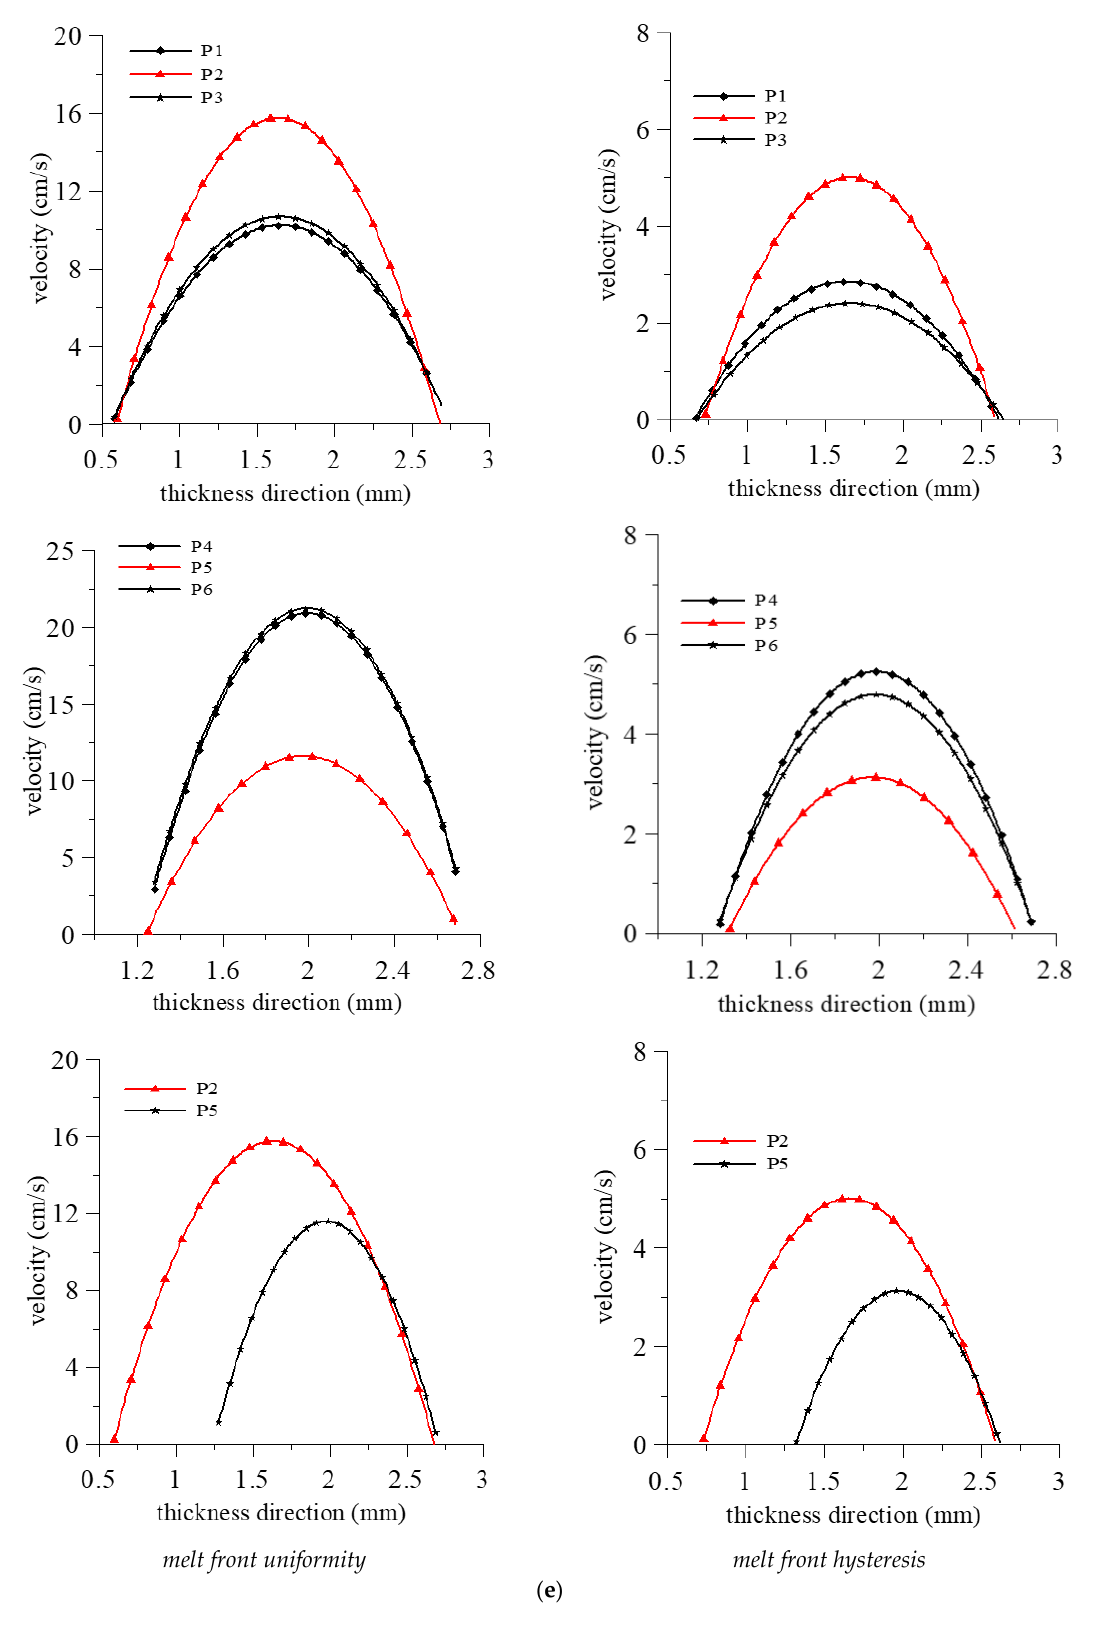
Figure 8. Viscous heating, temperature, and velocity distribution for different positions at 60% filling phage. ( a ) Viscous heating at P1, P2, P3. ( b ) Viscous heating at P1, P2, P3. ( c ) Viscous heating at P4, P5, P6. ( d ) Temperature distribution at P1–P6. ( e ) Velocity distribution at